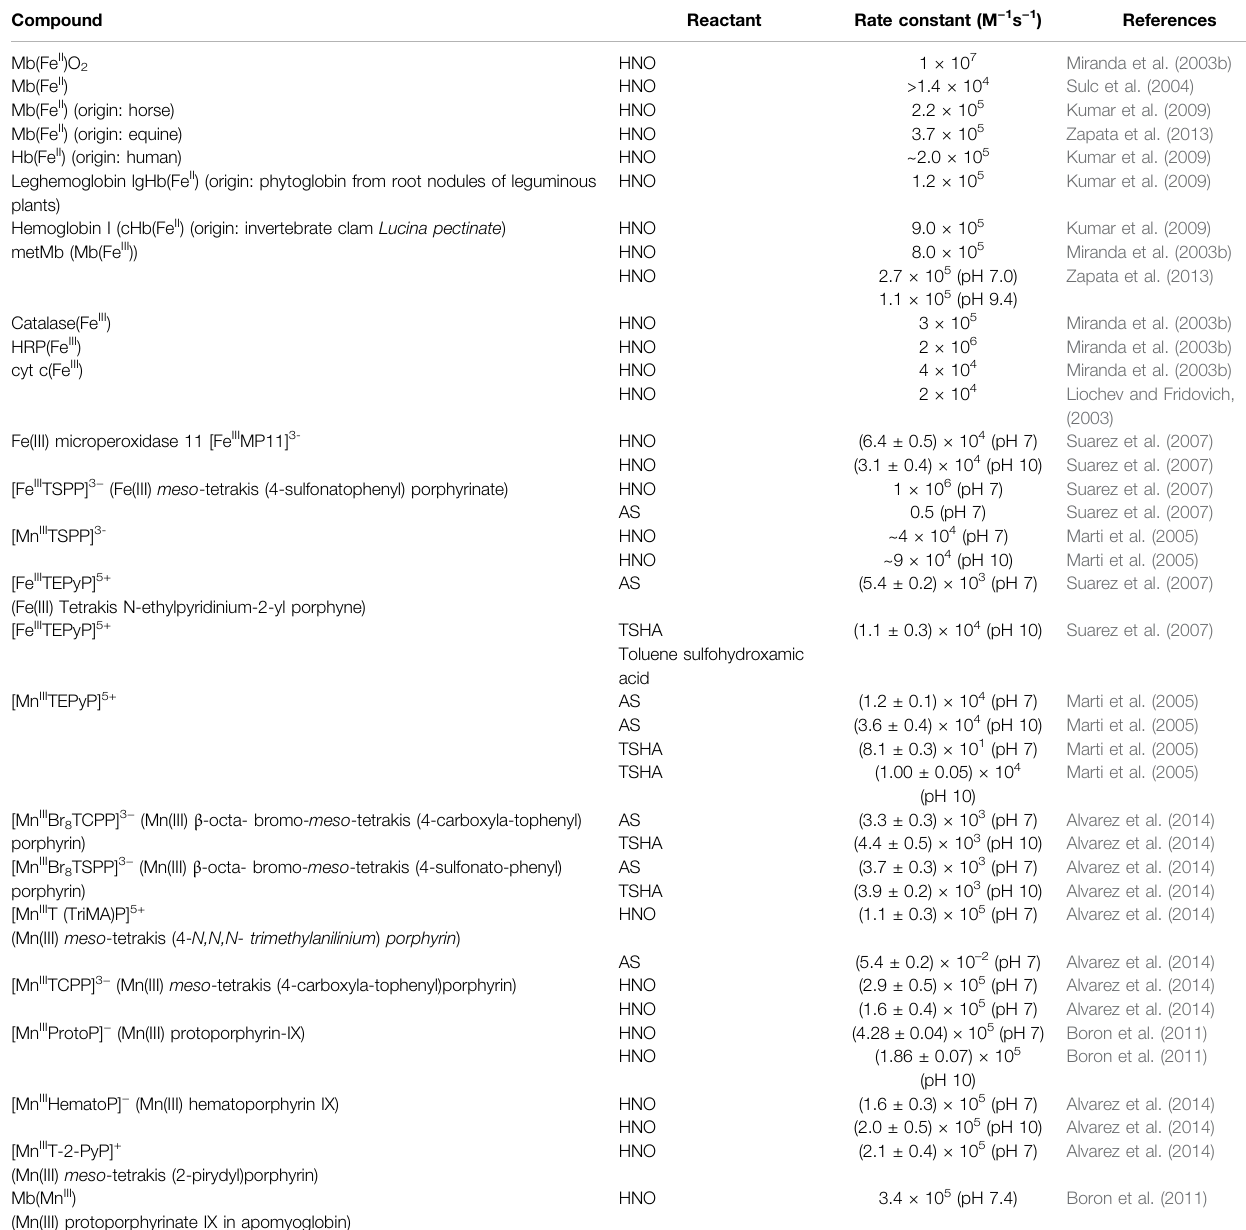
TABLE 2 | Second-order rate constants for reactions of porphyrins with HNO and HNO donors.